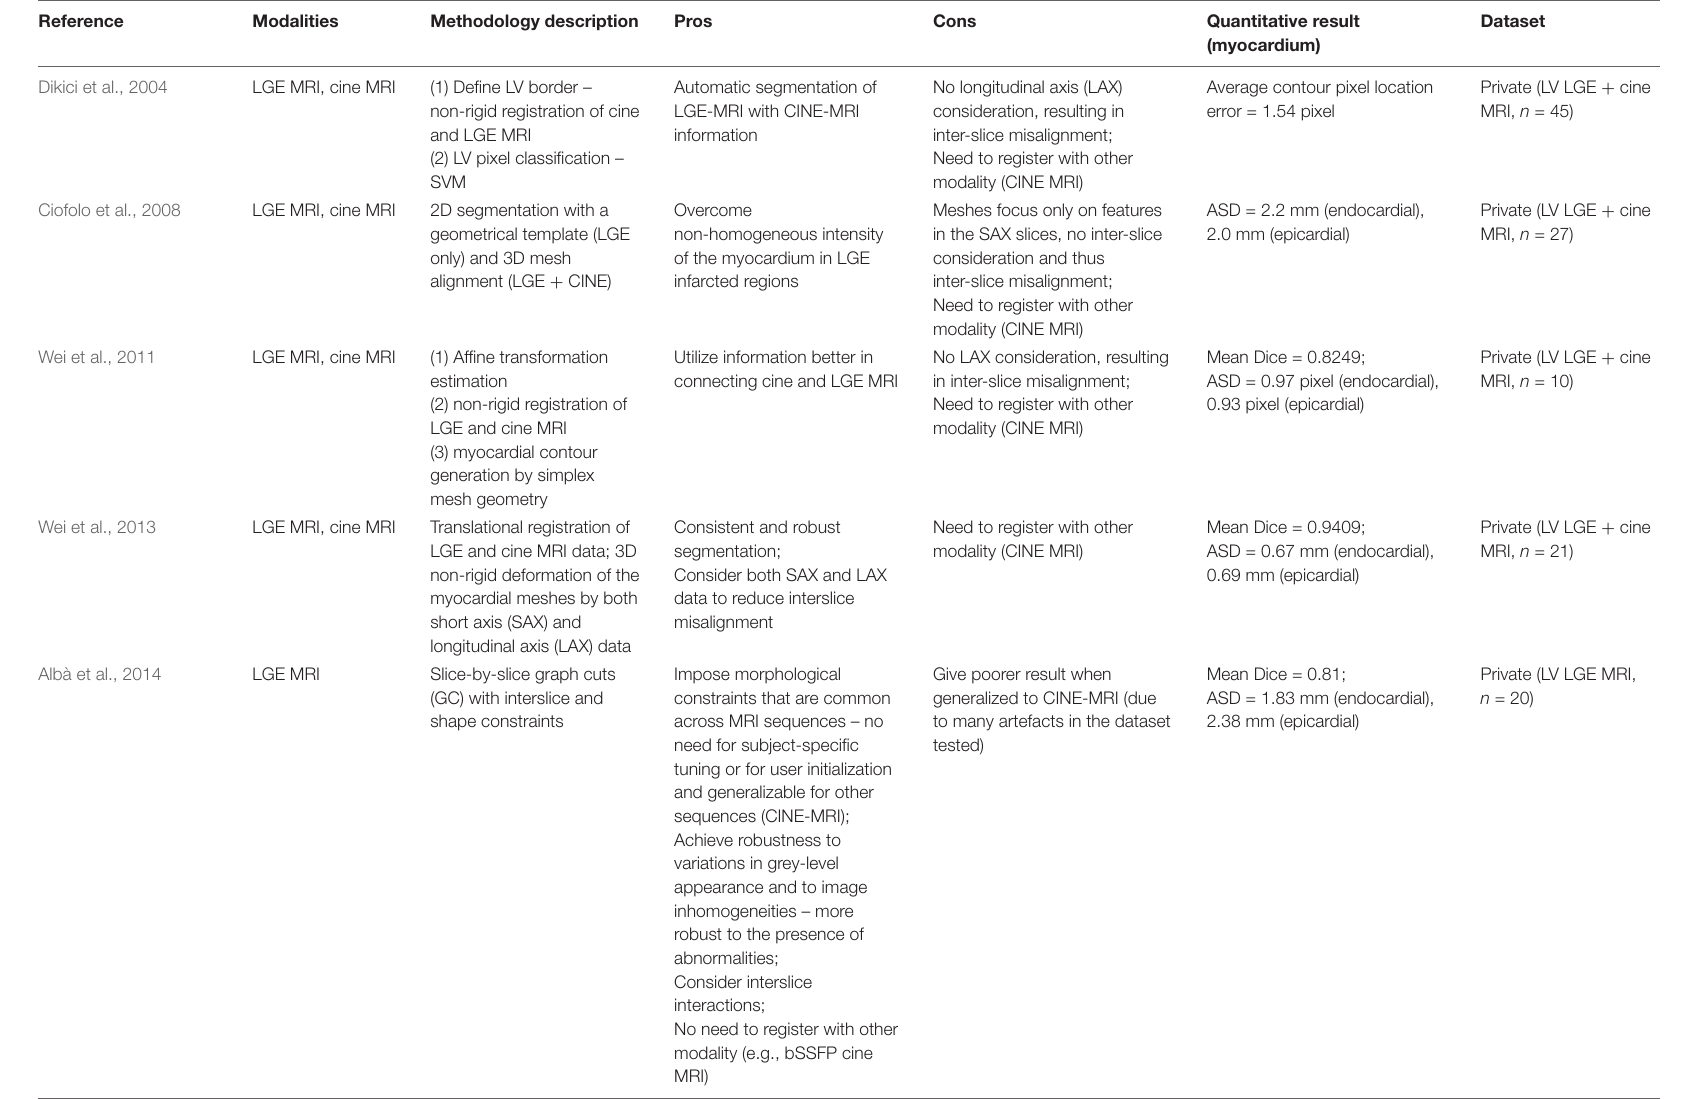
TABLE 2 | Summary of representative conventional methodologies for segmentation of the myocardium on LGE-MRI.